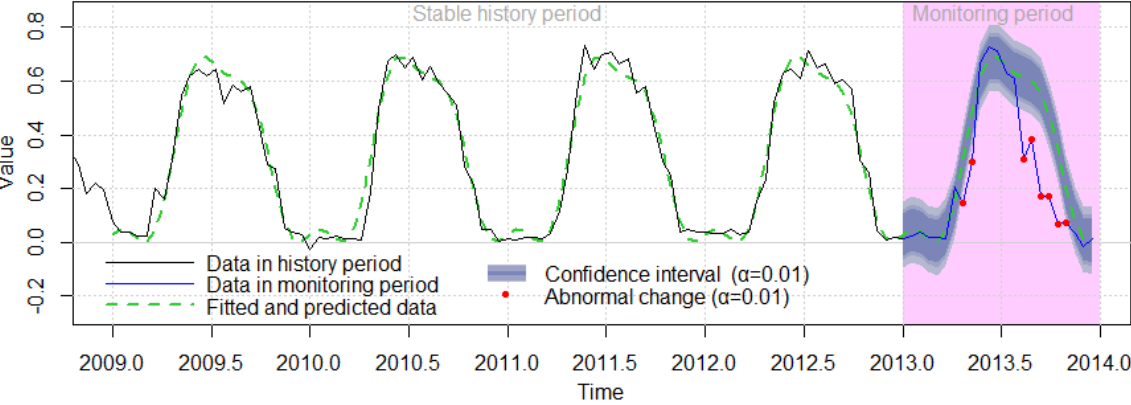
Figure 2. Illustration of detecting disturbances (anomalies or abnormal changes) according to the discrepancies between observations and